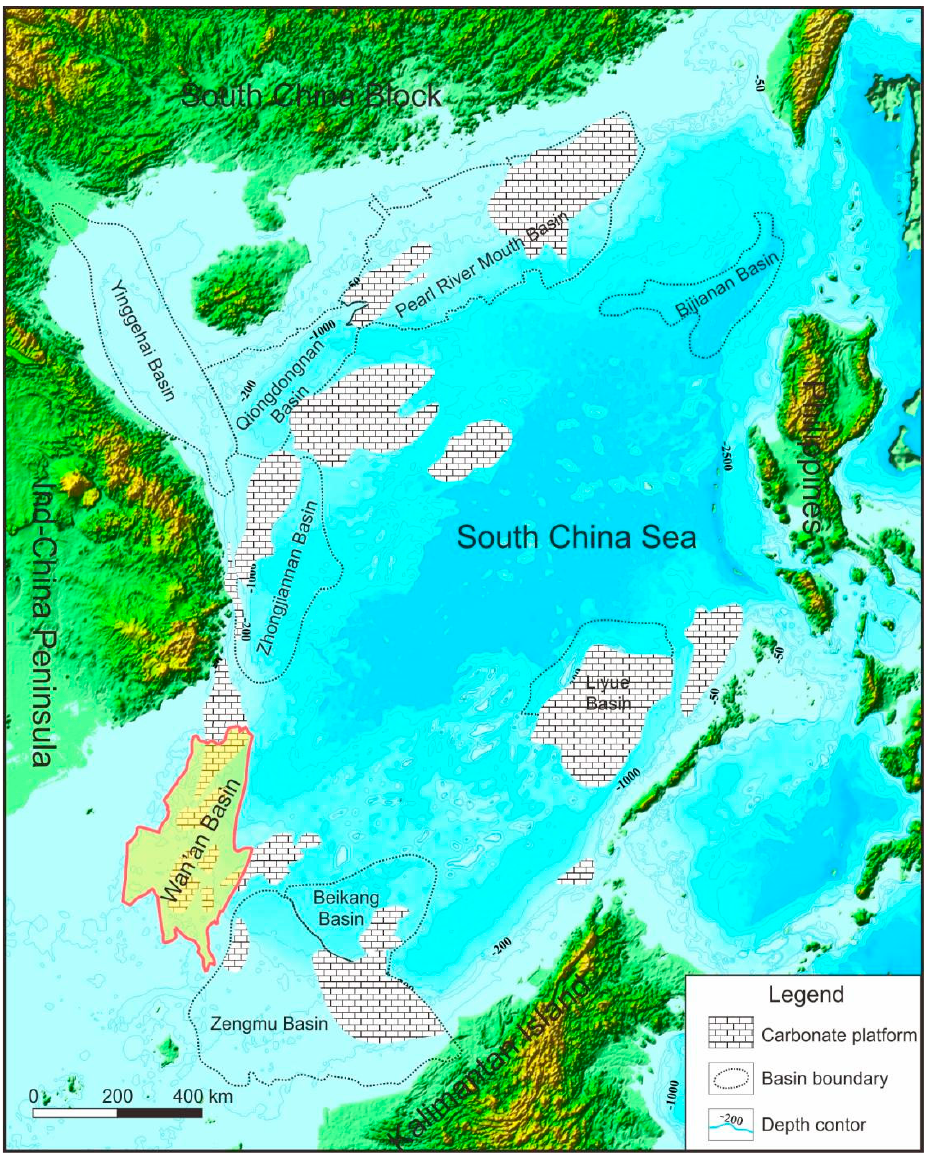
Figure 1. The location of study area in the South China Sea. The red enclosed area is the Wan’an